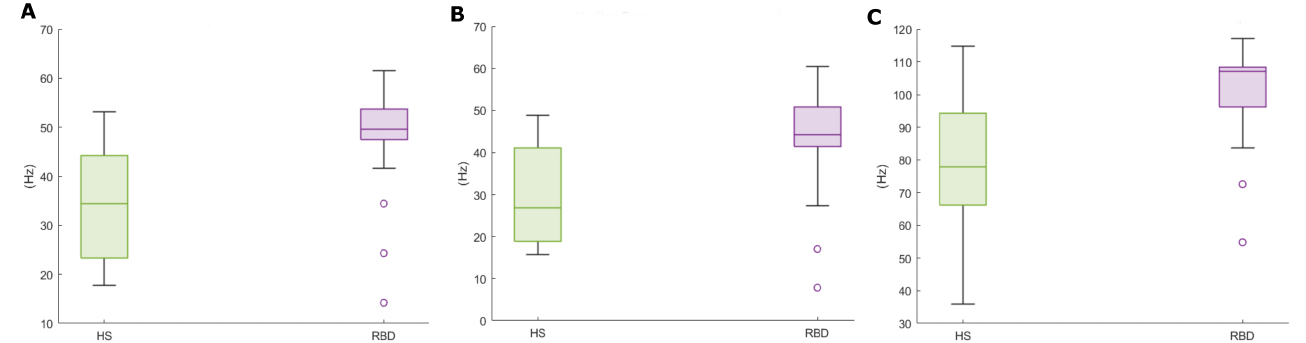
Figure 8. Spectral features boxplots, for above-threshold HS (green) and RBD subjects (purple). ( A ) Mean Frequency, ( B ) Median Frequency, ( C ) SEF95.